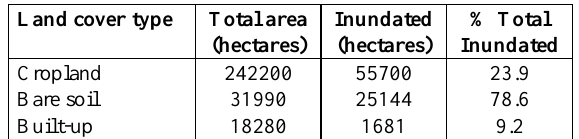
Table 4. Detail of area